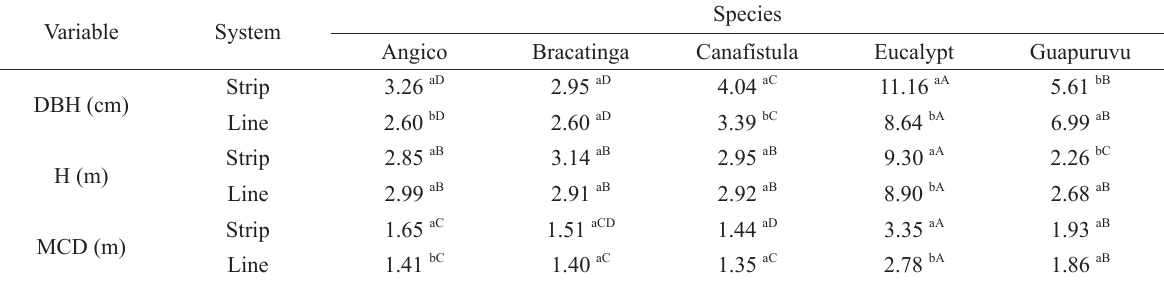
Diameter at breast height (DBH), plant height (H) and mean diameter of crown (MCD) of tree species angico, bracatinga, canafístula, eucalypt and guapuruvu in strip and line agroforestry systems in the city of Frederico Westphalen – RS. Species Variable System Angico Bracatinga Canafístula Eucalypt